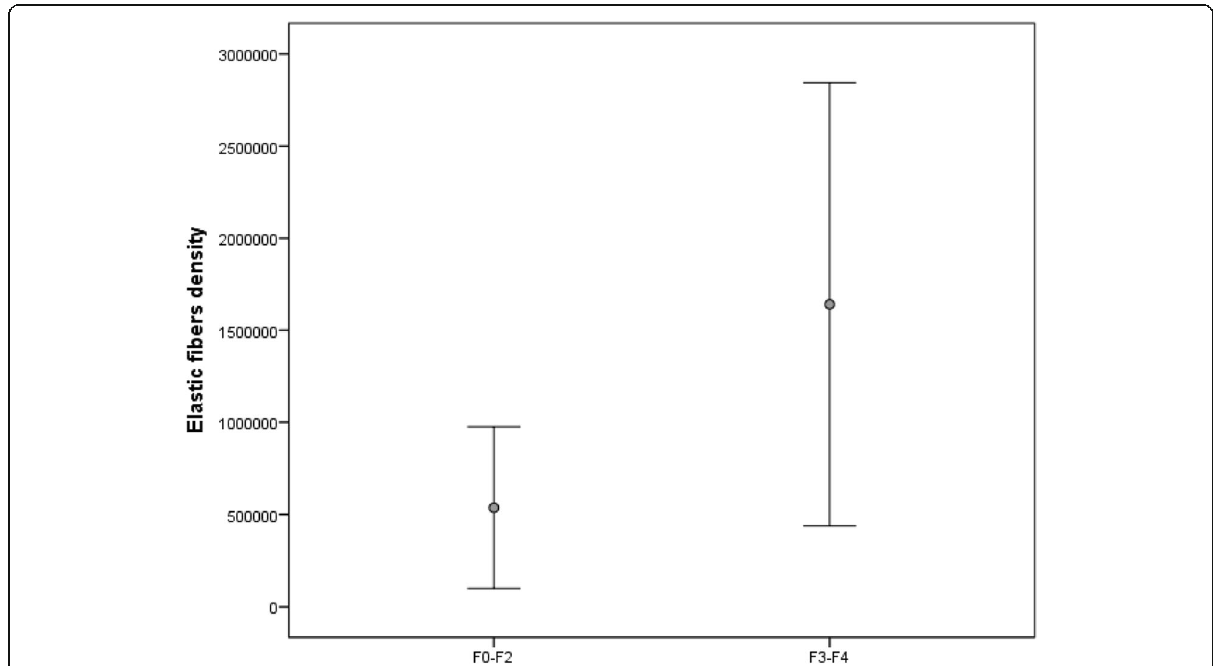
Fig. 2 Elastic fibers density in groups of early and advanced fibrosis. F0-F2: 536.72 × 10 3 absorbance-micrometer 2 (438.83 × 10 3 ) X F3-F4: